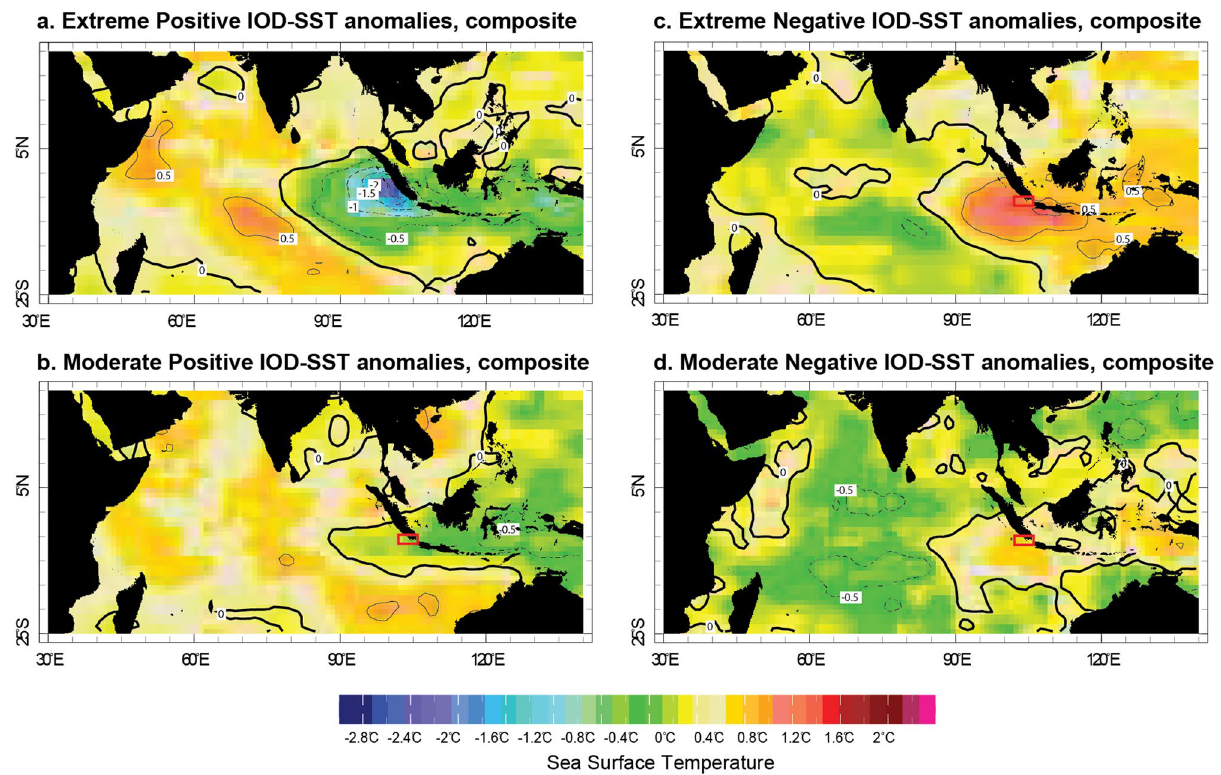
Figure 1. Composite maps of positive and negative IOD events. September–November SST anomalies during extreme (moderate) positive ( a , b ) and negative ( c , d ) IOD events. SST data is from the OISST v2 dataset. IOD events are classified according to the Australian Government Bureau of Meteorology (http:// www. bom. gov. au/ clima te/ iod/). Red rectangle includes Enggano Island (modern coral record) and Lampung Bay (MCA coral record). Map is generated using expert mode menu in https:// iridl. ldeo. colum bia. edu/ SOURC ES/. NOAA/. NCDC/. OISST/. versi on2/. AVHRR/.